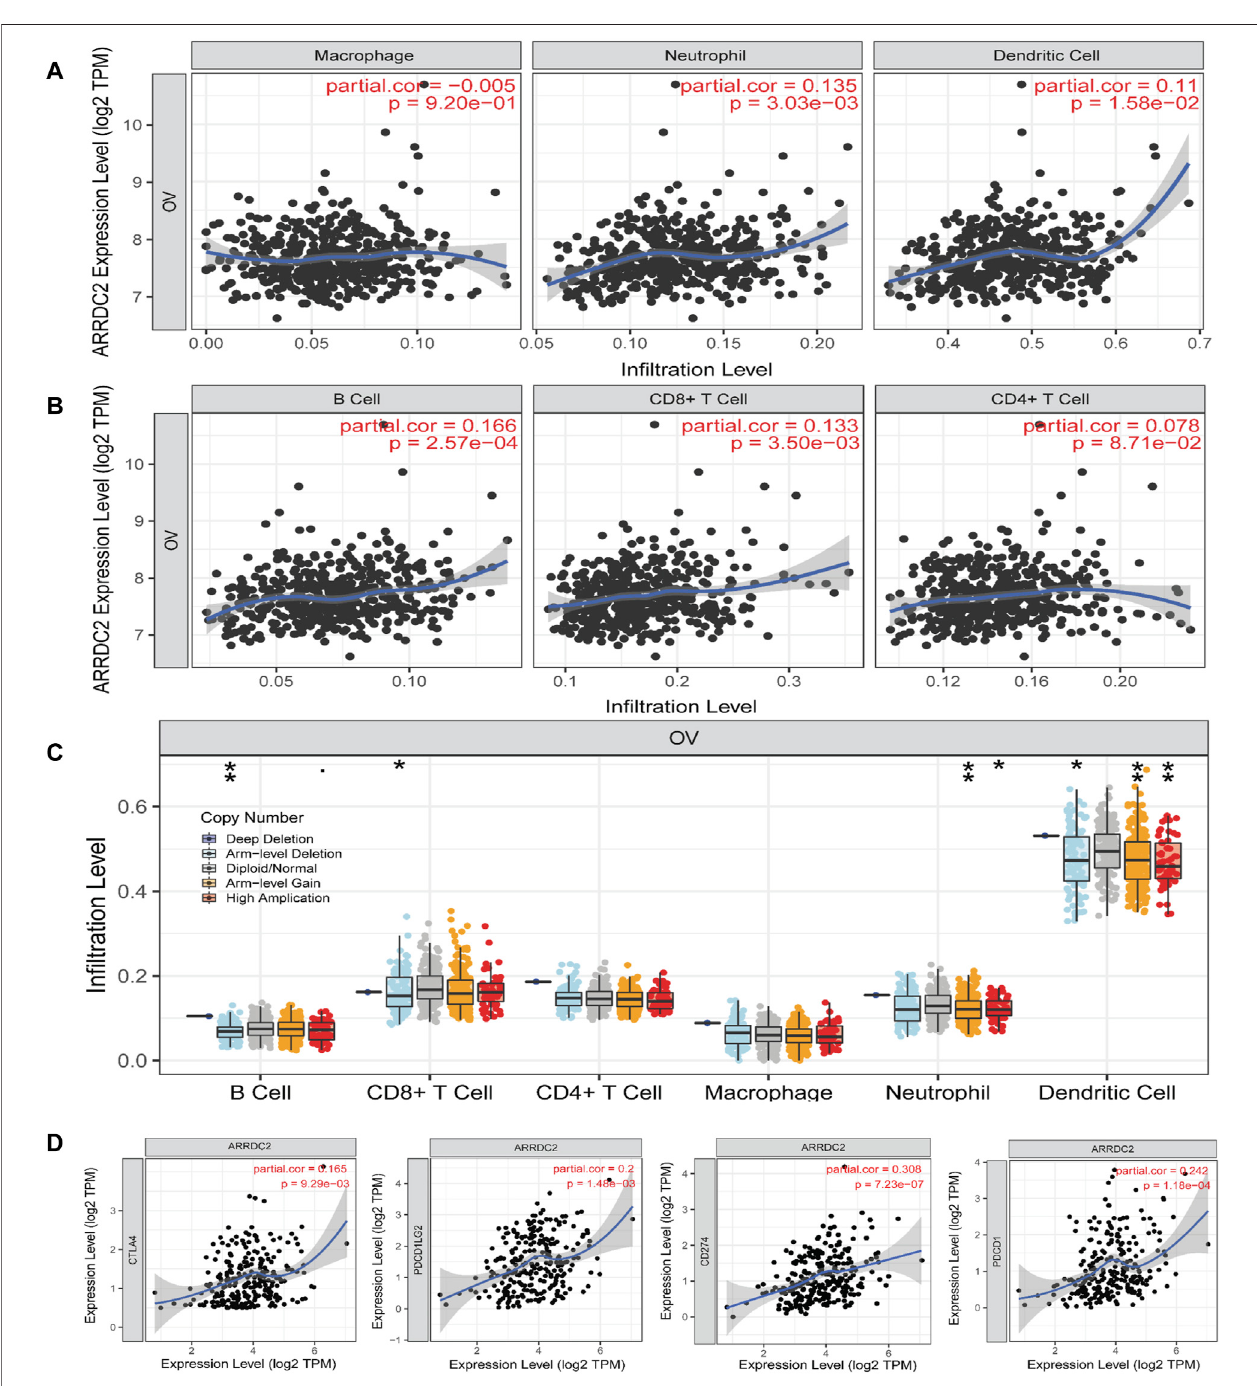
FIGURE 4 | Therelationshipbetween theexpressionofARRDC2 and proportionofimmunein fi ltratesinTIMER database. (A,B) In fi ltrationofvarious immunecells. (A) Macrophage, Neutrophil,Dendritic Cell. (B) B Cell, CD8+ T Cell, CD4+ T Cell. (C) Association between ARRDC2 gene copy number and immune cellin fi ltration levels in OV cohorts(* p < 0.05;** p < 0.01;*** p < 0.001;**** p < 0.0001). (D) InTIMERdatabase,therelationshipbetweenImmunecheckpoint(CTLA4,PDCD1,CD274,PDCD1LG2)and ARRDC2 gene expression was analyzed by Spearman correlation analysis ( p < 0.05). Correlation coef fi cients (rho values) and p values were shown.